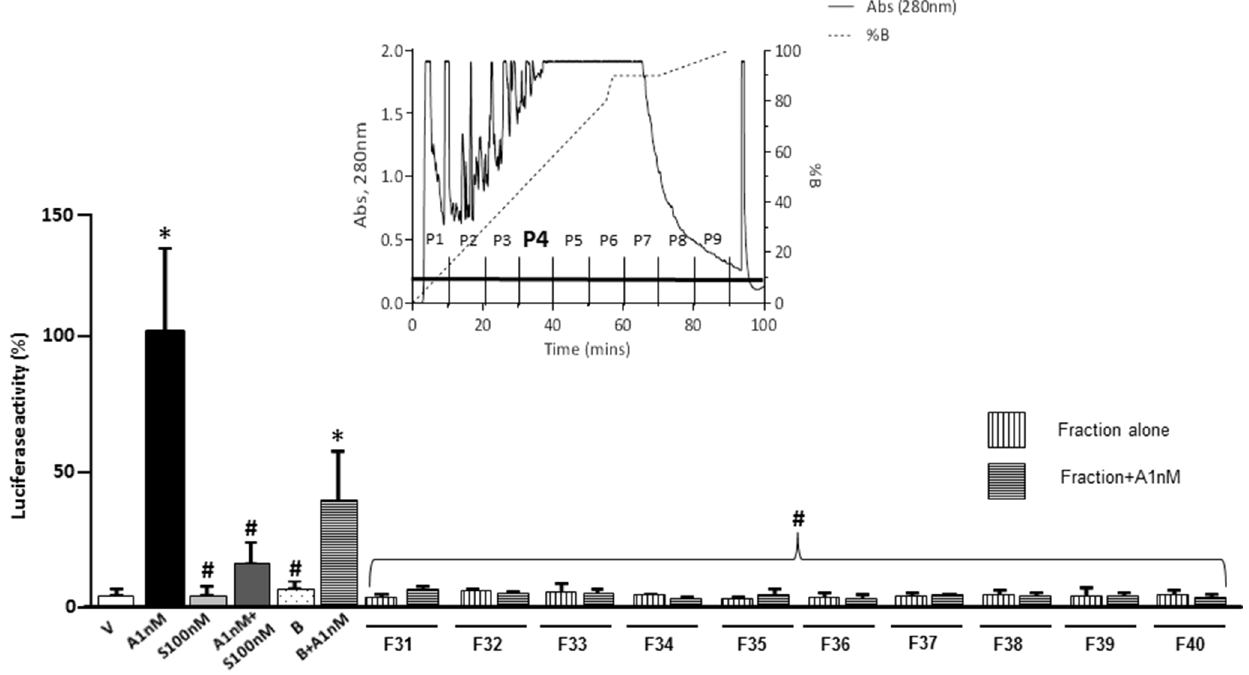
Figure 6. Effect of P4 individual fractions on aldosterone-induced human mineralocorticoid receptor (hMR) transcriptional activity. CV-1 cells transfected with hMR expression and MMTV-LUC reporter plasmids were treated with vehicle (V) or aldosterone 1 nM (A1 nM) in presence of spironolactone 100 nM (S100 nM) or fractions (F) 31 to 40 (1 m M), blank (B) and blank + aldosterone1 nM (B + A1 nM). Each data point represents the mean 6 SEM derived from 3 independent experiments. *p , 0.01 vs V; { p , 0.05 vs. A1 nM.